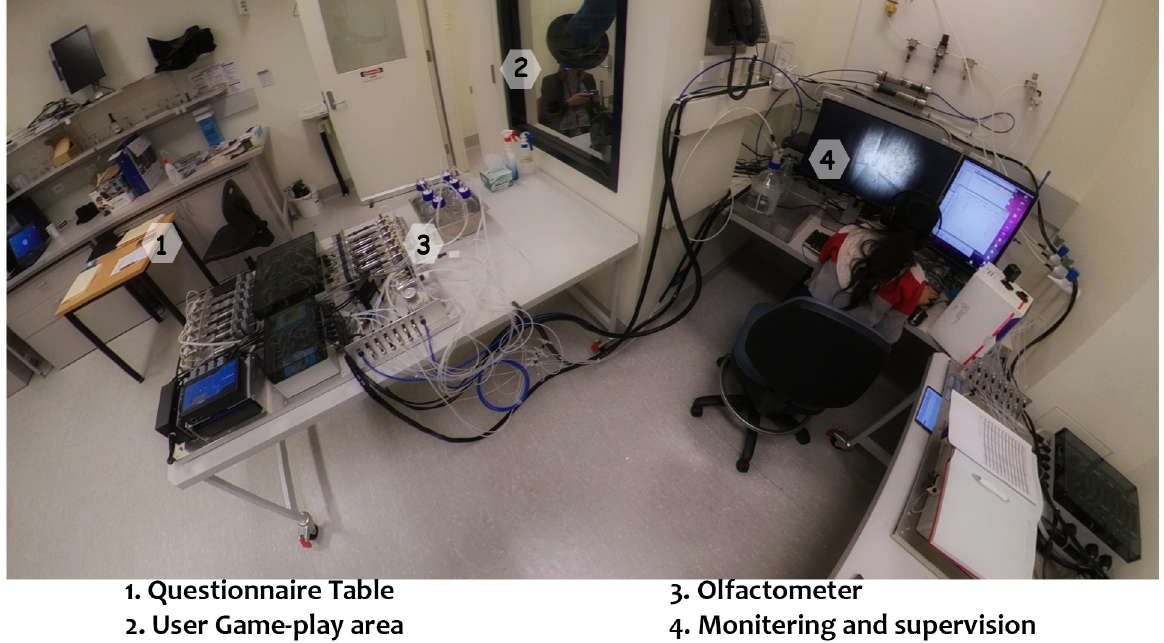
Fig 1. Overview of experimental set-up for the study. Zone 1: participant briefing and post-gameplay questionnaires, Zone 2: the gameplay area, Zone 3: olfactometer, and Zone 4: the monitoring/supervision area.